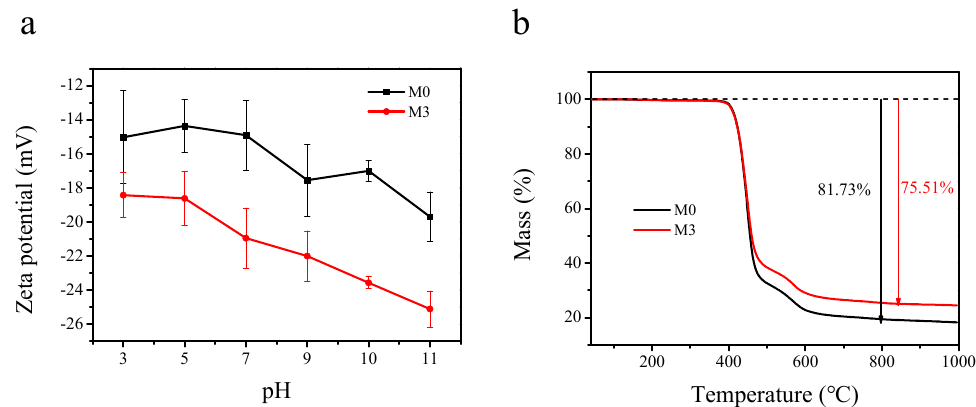
Figure 8. Zeta potential ( a ) and TGA curves ( b ) of pristine membrane and PES/MoS 2 @PDA Membrane.